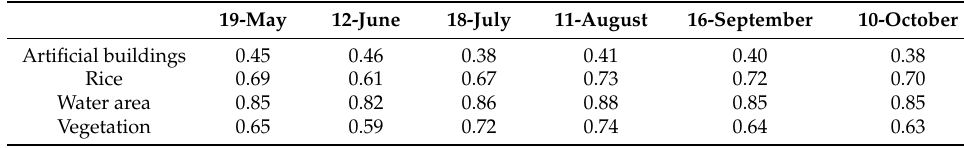
Table 7. VV/VH polarization backscatter coefficient of ground